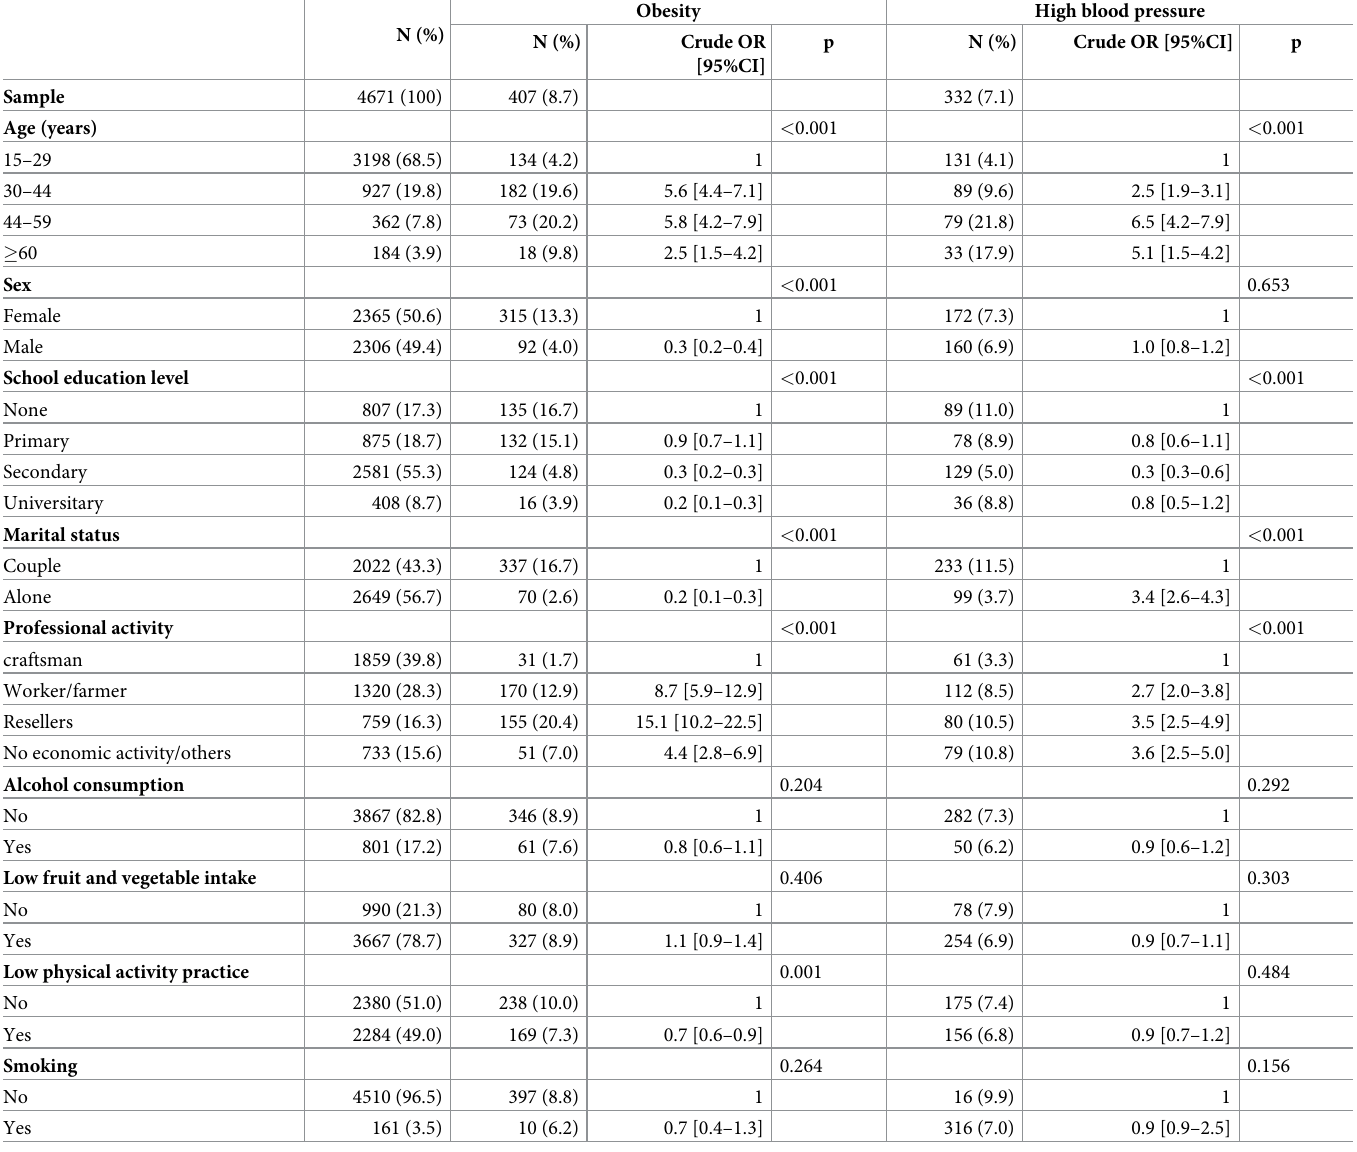
Table 1. Prevalence of obesity and high blood pressure according to socio-demographic and behavioral characteristics, Parakou